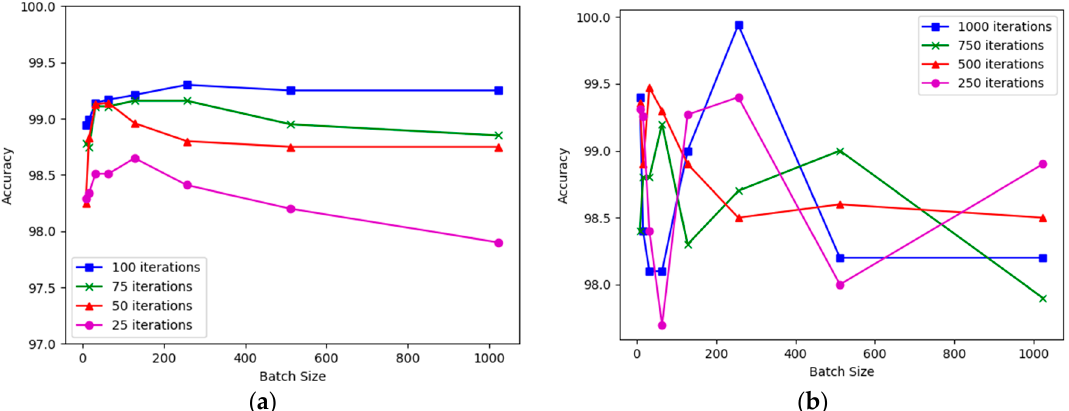
Figure 10. Parameter tuning: ( a ) batch size vs accuracy for LSTM network, ( b ) batch size vs accuracy for CNN network. The convergence is faster in LSTM rather than CNN in terms of the number of iterations.